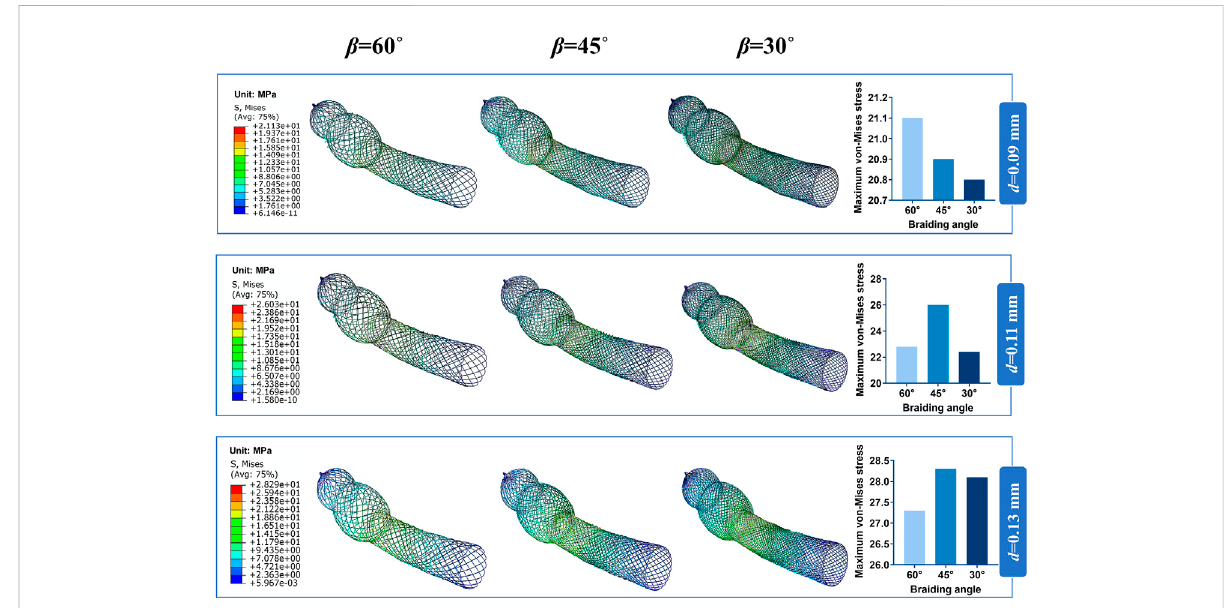
FIGURE 7 Contour plots of von-Mises Stress of the bended nasal stent: Stent model S.